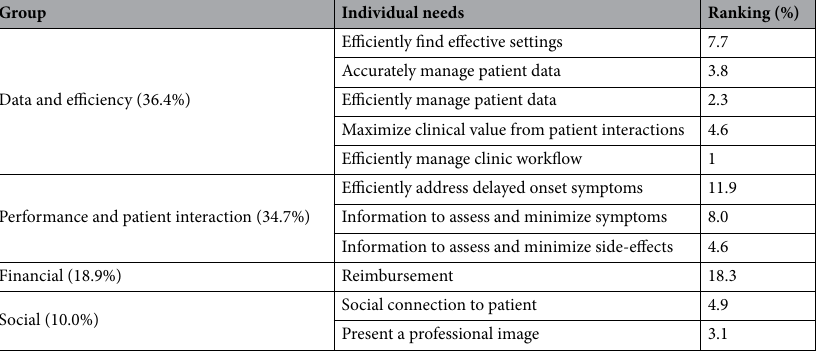
Table 2. Clinician needs grouping and ranked